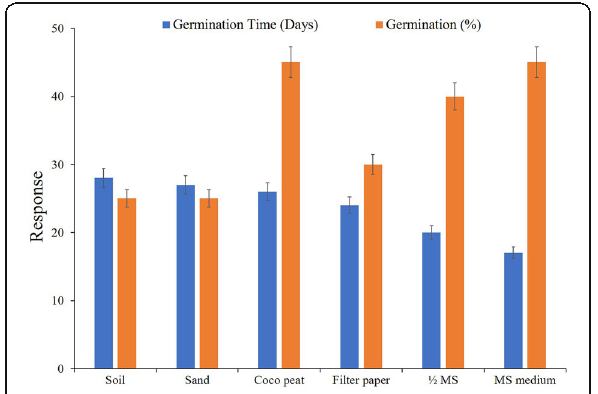
Fig. 1 Seed germination response of Tricholepis roylei in different